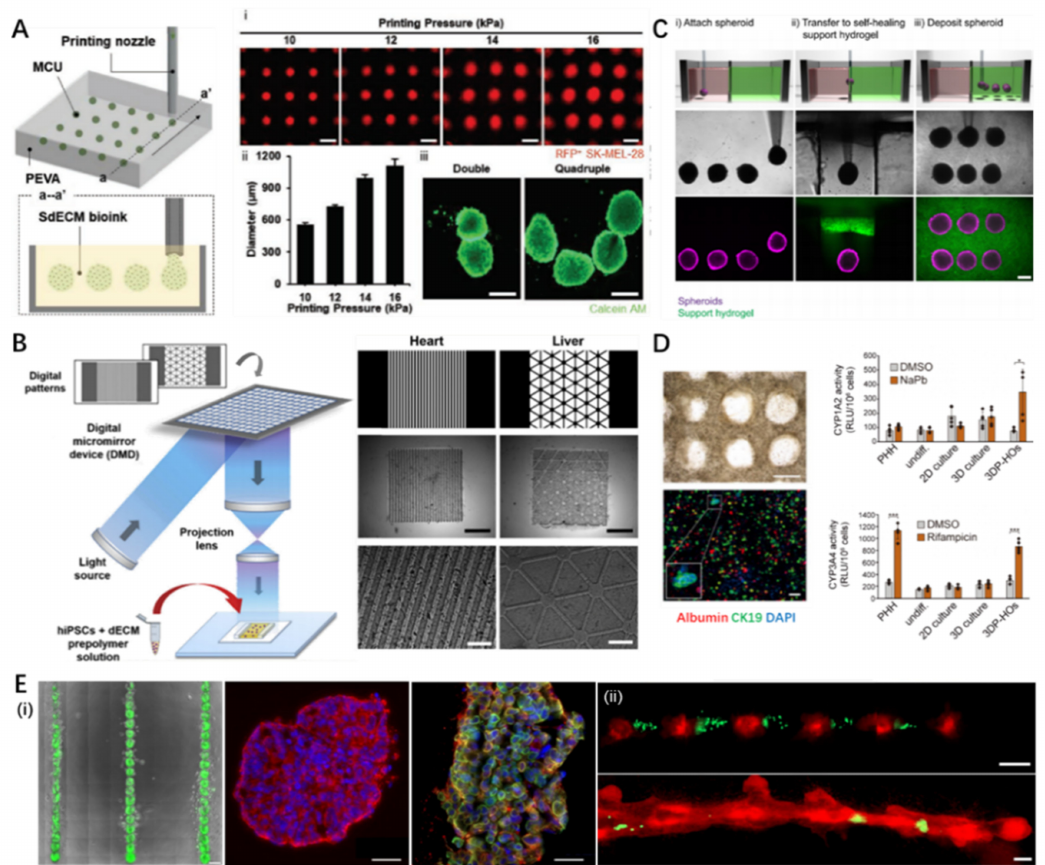
Figure 4. Representative 3D bioprinted organoids and pharmaceutic applications. ( A ) The concept of in situ 3D bioprinting of cell aggregates and its potential for in situ printing of cancer organoids: (i) size control of spheroids by altering printing pressures; (ii) quantification of spheroids dimensions varied with printing pressure; (iii) stained images of double/quadruple melanoma organoids (scale: 500 µ m). Reproduced with permission from [116], John Wiley and Sons, 2021. ( B ) Schematic and image demonstrating the 3D bioprinted spheroids in self-healing support hydrogels. Reproduced with permission from [117], Elsevier, 2019. ( C ) STL-based rapid 3D bioprinting process to fabricate dECM tissue constructs with tissue- specific iPSCs and biomimetically patterned heart and liver dECM tissue constructs. Reproduced from [121], Springer Nature, 2021. ( D ) 3D bioprinted hepatorganoids on day 10 and the P450-Glo assay of cytochrome activity (CYP1A2, CYP3A4) in the hepatorganoids after 7 days of differentiation. Reproduced with permission from [123], BMJ Publishing Group Ltd., 2021. ( E ) (i) 3D bioprinted patterned tumoroids and desired tumor cytokine expression (red: CK-8, green: CK-5, scale: 100 µ m), (ii) alternative 3D bioprinting of MDA-MB-468 cells (green) and MCF-12A cells (red) at day 1 (up) and day 7 (down) demonstrating incorporation of cancer cells into the organoid (scale: 200 µ m). Reproduced from [130], Scientific reports, 2019. STL, stereolithography; dECM, decellularized extracellular matrix; iPSCs, induced pluripotent stem